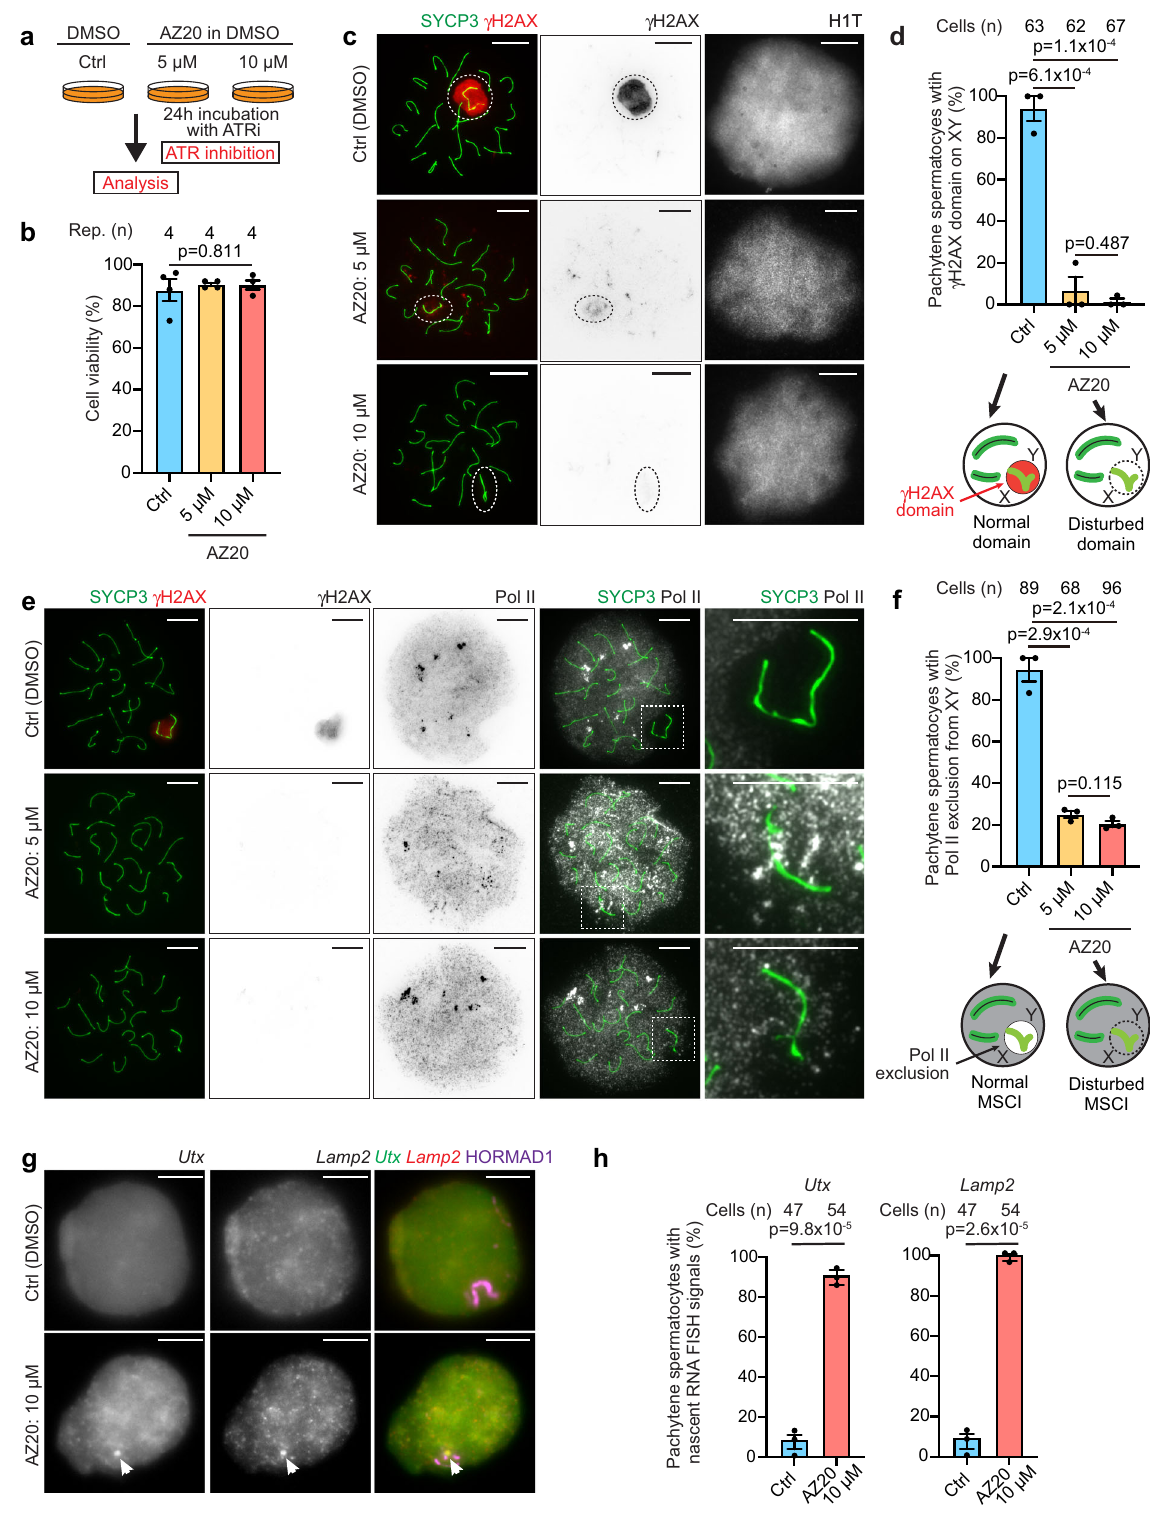
ATRandTOPBP1arerecruitedtoproximalnucleosomes,H2AXisagain phosphorylated, MDC1 binds γ H2AX, more ATR and TOPBP1 are incorporated, and so on 14 (Fig. 3a).